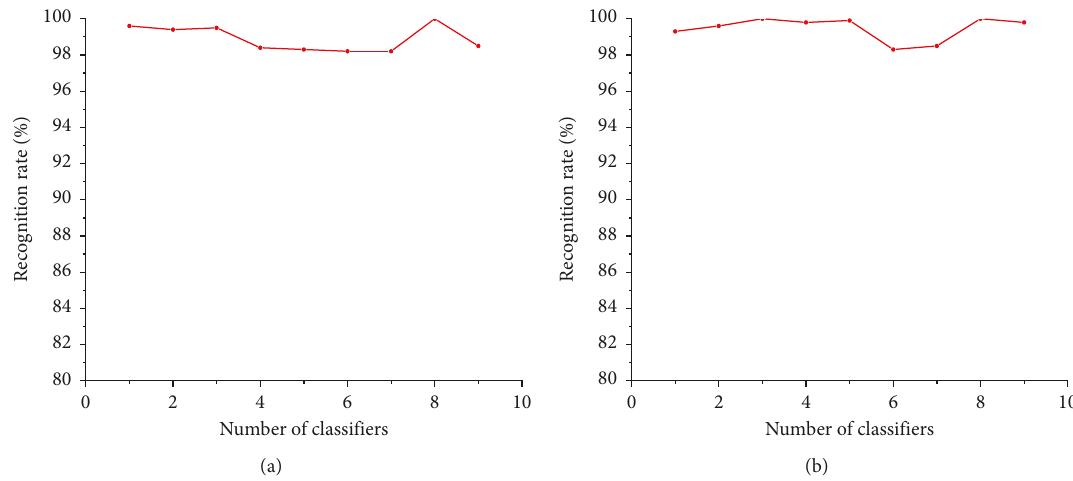
Figure 8: The recognition rate of the number of weak classifiers in the AdaBoost algorithm. (a) Recognition rate of fist movement. (b) Recognition rate of palm valgus.